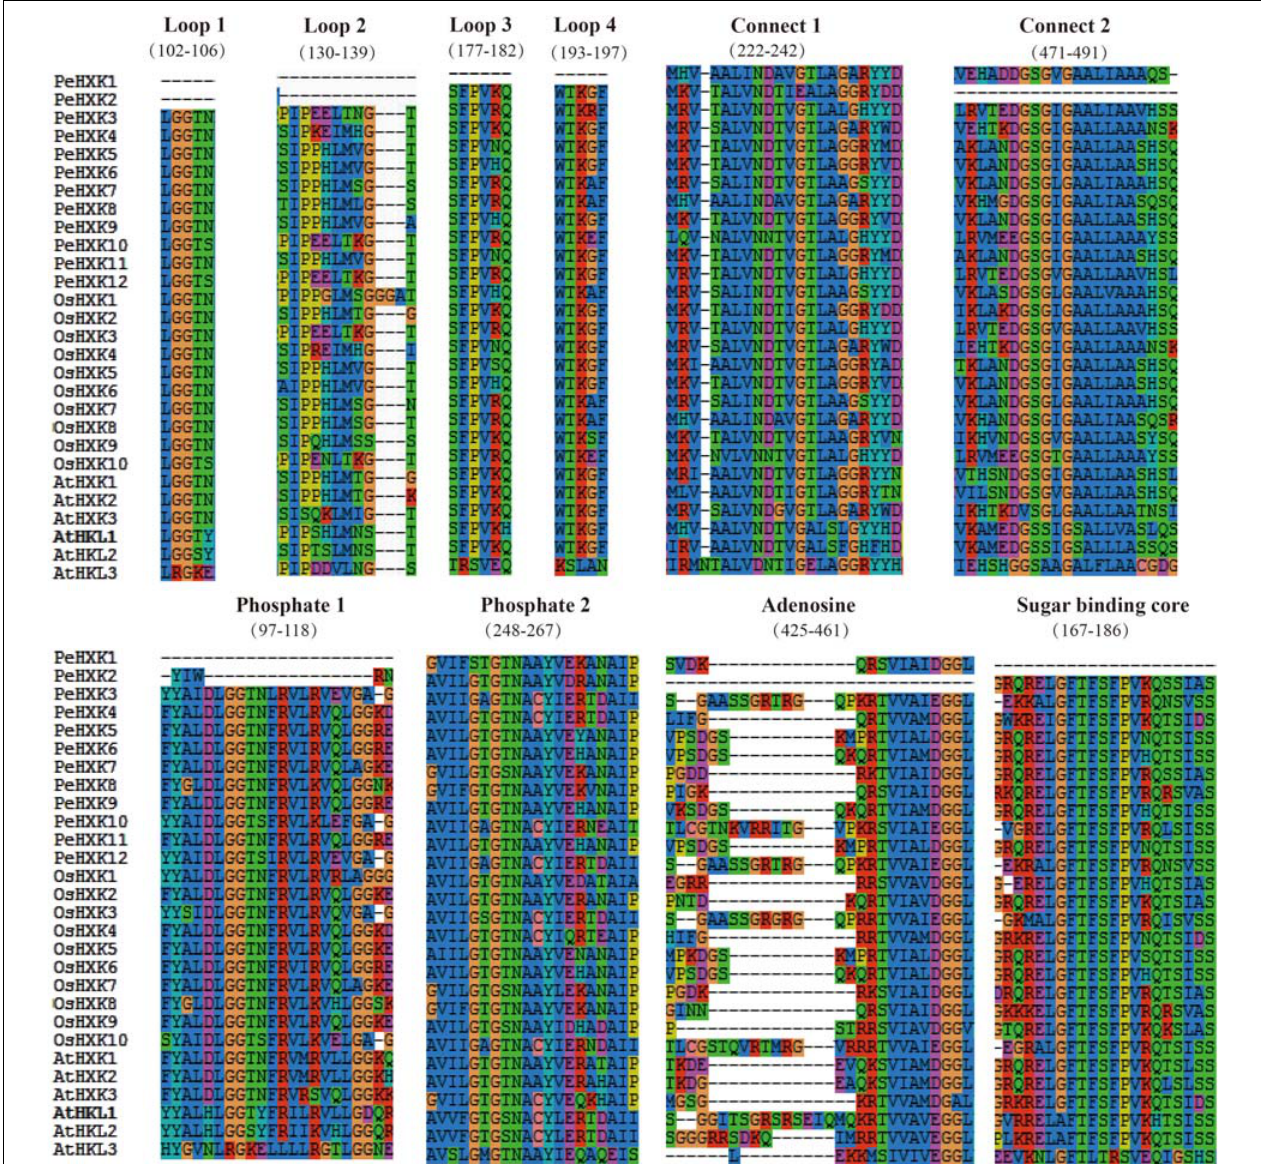
FIGURE 2 | Gene structure of HXKs in moso bamboo, Arabidopsis thaliana , and rice. The HXKs were divided into five distinct sub-groups marked as left. It was specially noted that PeHXK6 and PeHXK9 genomic sequences contain much longer introns, while only OsHXK1 has no intron in the genome at all. The exons, introns, and UTR sections are indicated by yellow rectangles, black lines, and blue rectangles,